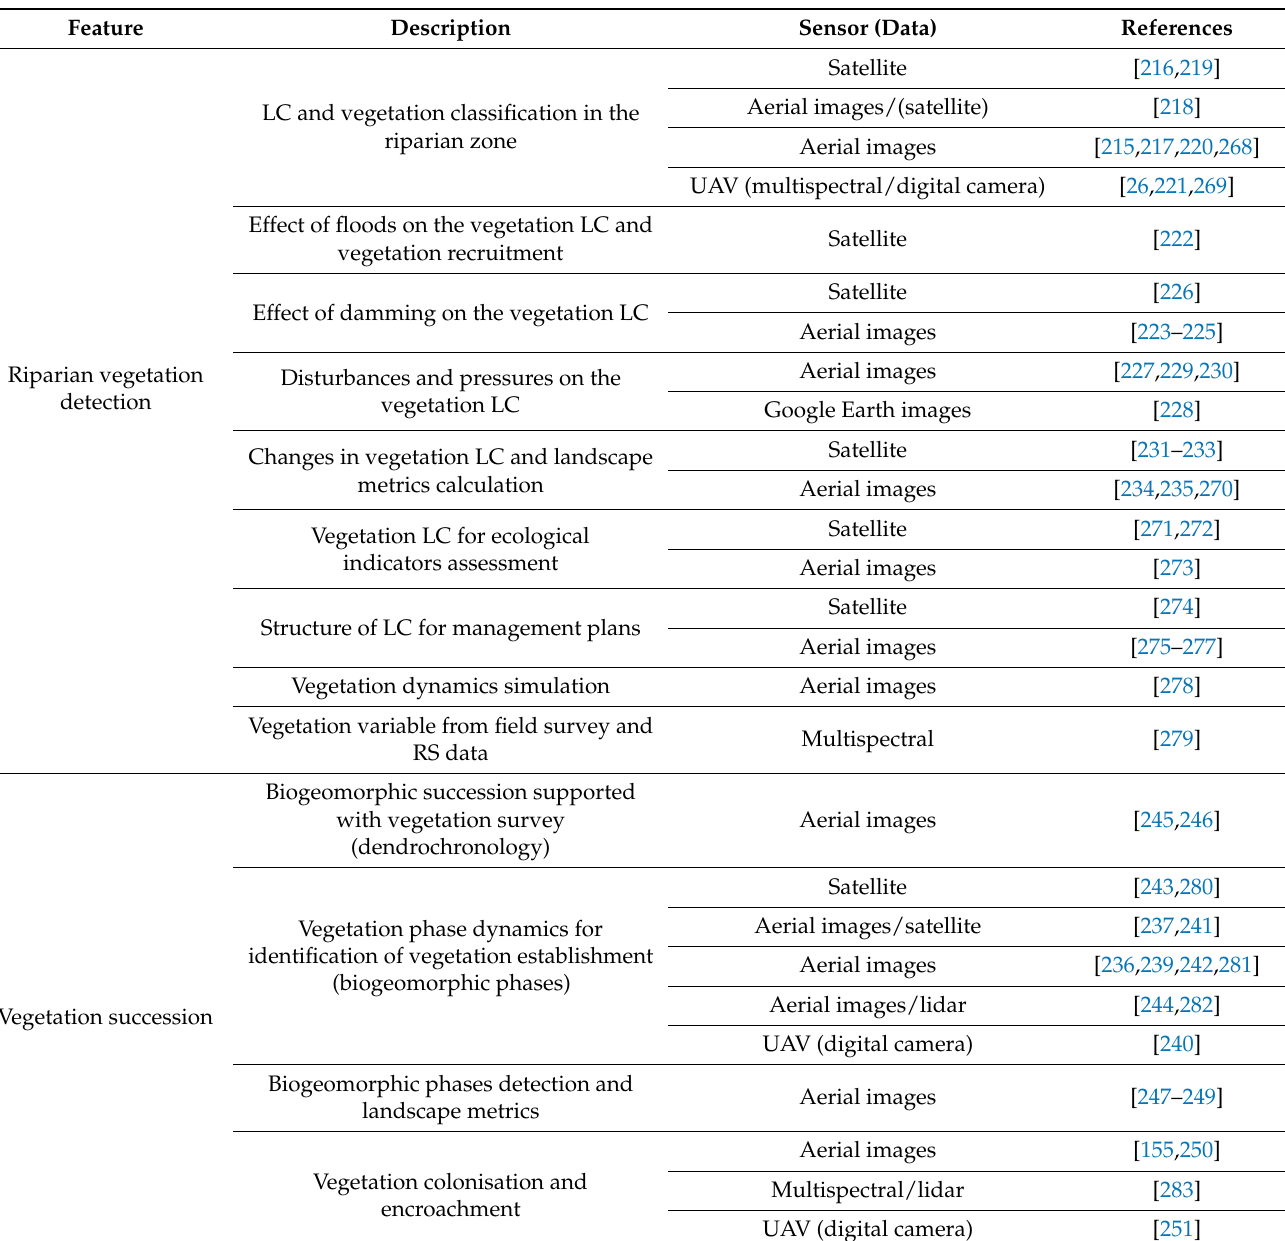
Table 5. Vegetation detection, successional phase identification, and individual species population classification in the riparian zone. Studies are sorted based on a short description of the methodologies and sensors